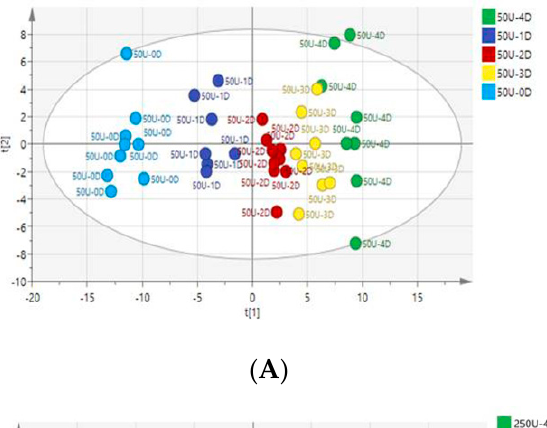
Figure 5. Score plot of OPLS-DA obtained based on the urine samples from the 50-unit group ( A ) and 250-unit group ( B ).